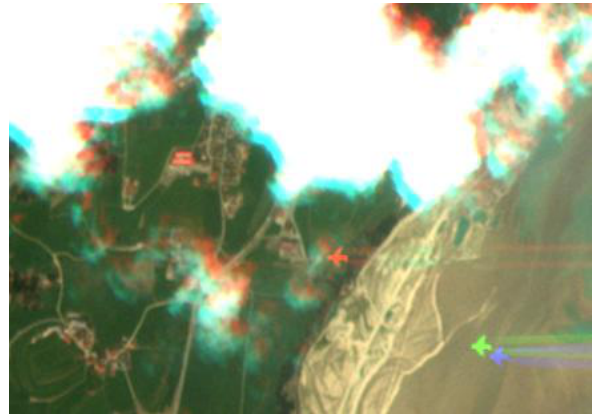
Figure 1: Section 2 . 1 × 1 . 5 km from a RapidEye scene of southern bavaria (north of F¨ussen) containing clouds and a plane Fig. 1 shows a part of a RapidEye scene containing clouds and a plane travelling from east to west. The different positions of